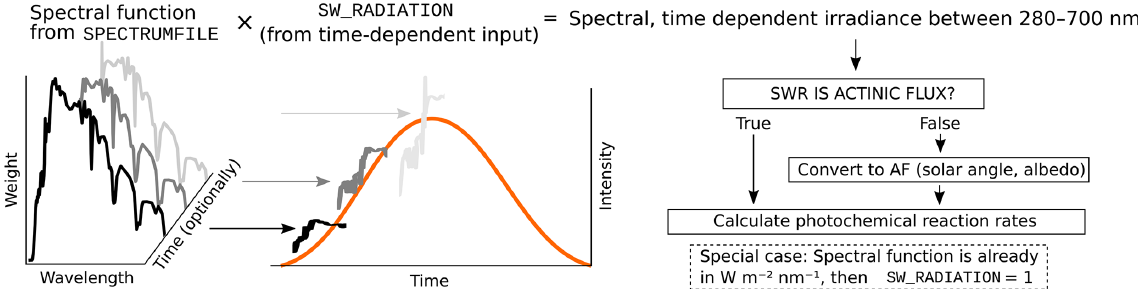
Figure 2. Schematic representation of how actinic flux is calculated from the provided input.